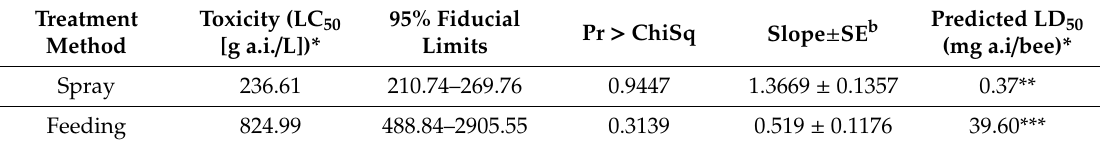
Table 3. Spray and feeding toxicity (48 h) of methyl benzoate to honey bee